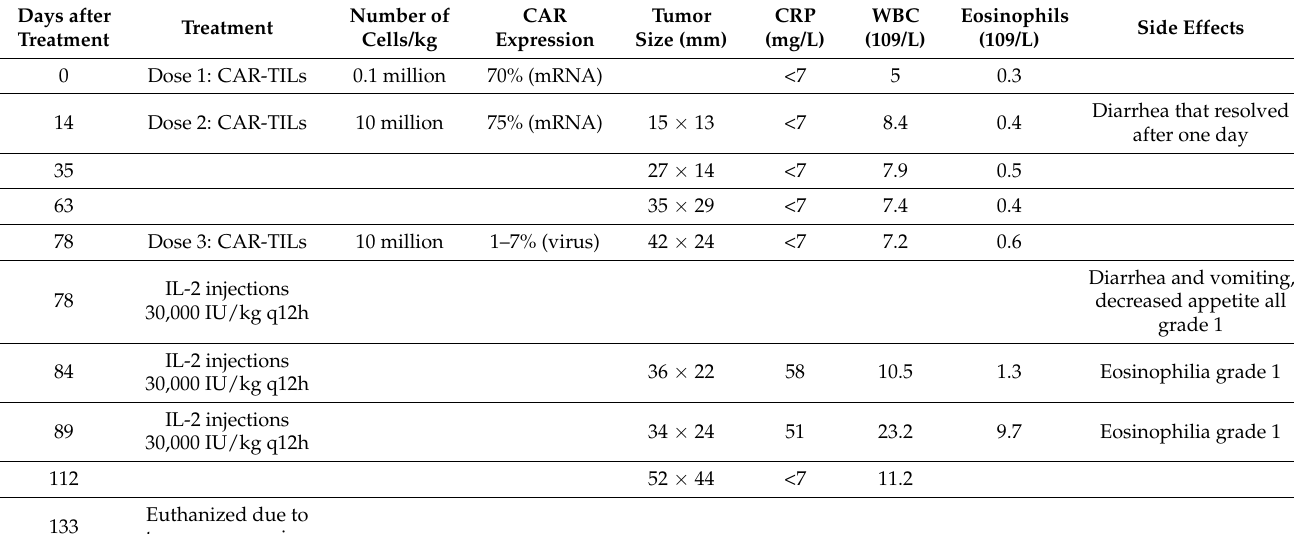
Table 1. Clinical responses to CAR-TIL treatment of Dog 3. Abbreviations used: CRP, C-reactive protein, and WBC, white blood cell count.